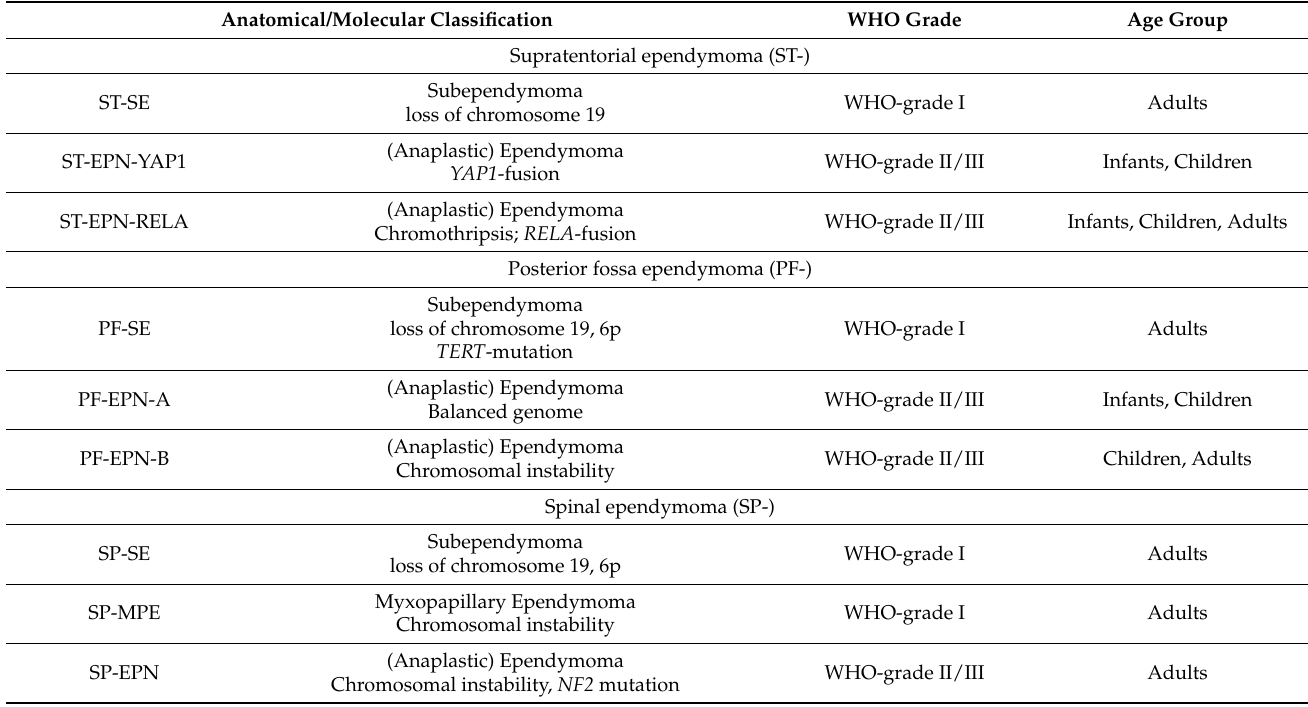
Table 4. Molecular subgroups of ependymoma